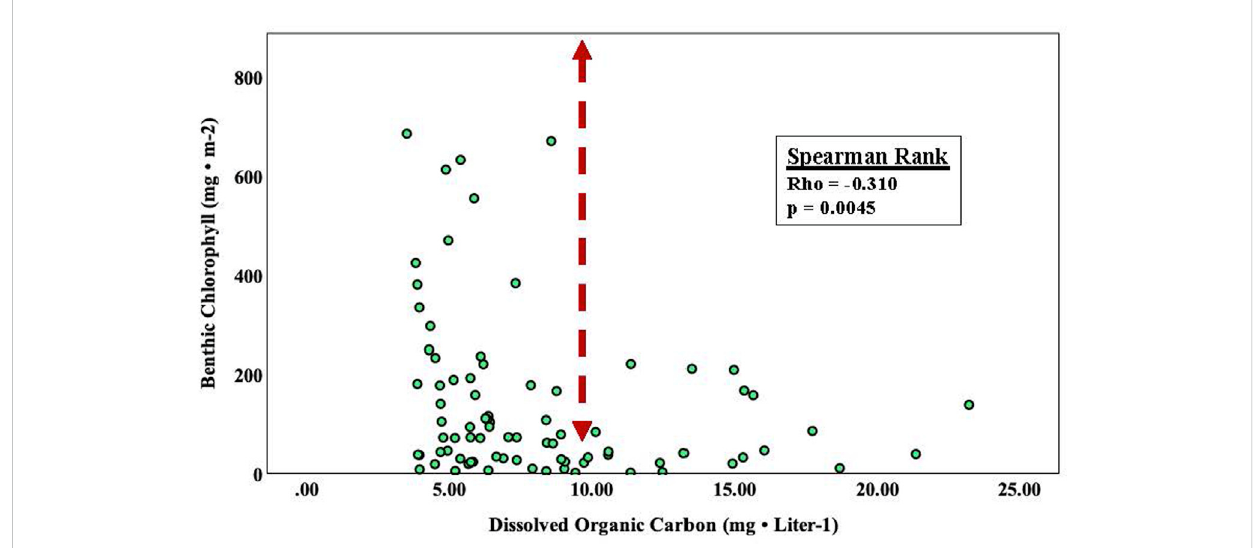
FIGURE 5 Seasonal survey data assessing the relationship between benthic algal chlorophyll concentrations and stream DOC at 14 samples locations within the Chippewa River